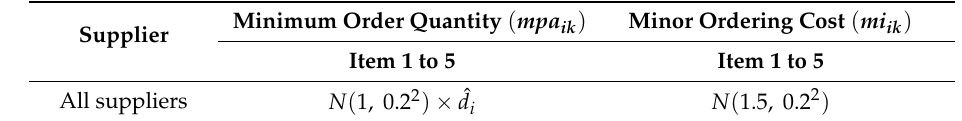
Table 5. Input parameters for each item of each supplier.